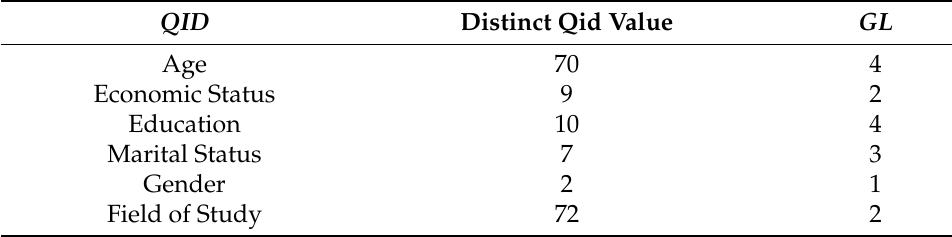
Table 6. Irish dataset.